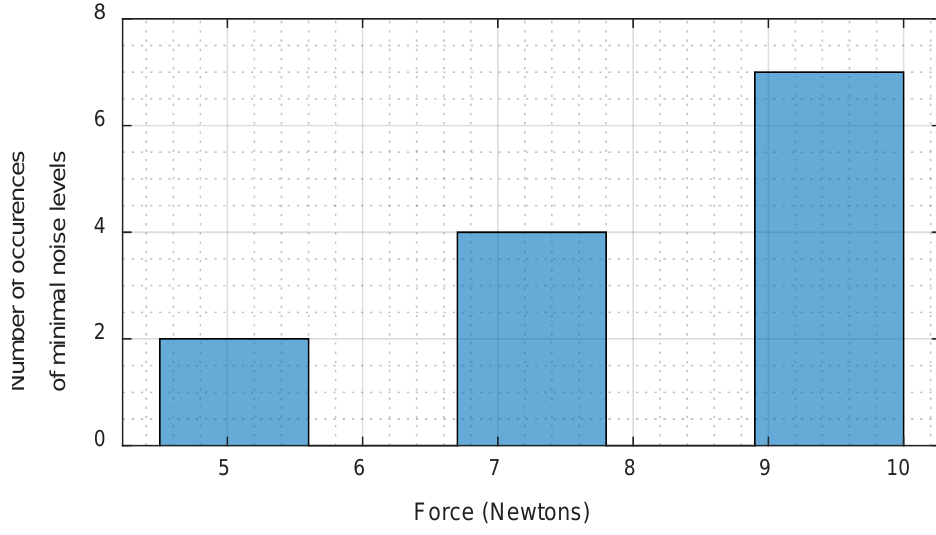
Figure 8. Histogram of RMS force levels associated with minimal noise levels across